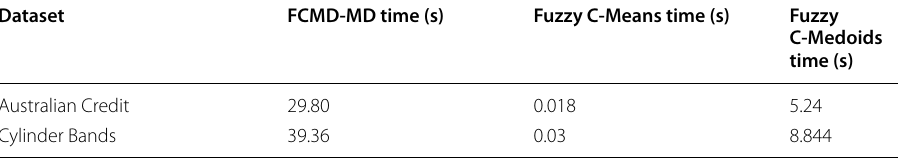
Table 5 Time consumption comparison of FCMD-MD with Fuzzy C-Means and Fuzzy C-Medoids